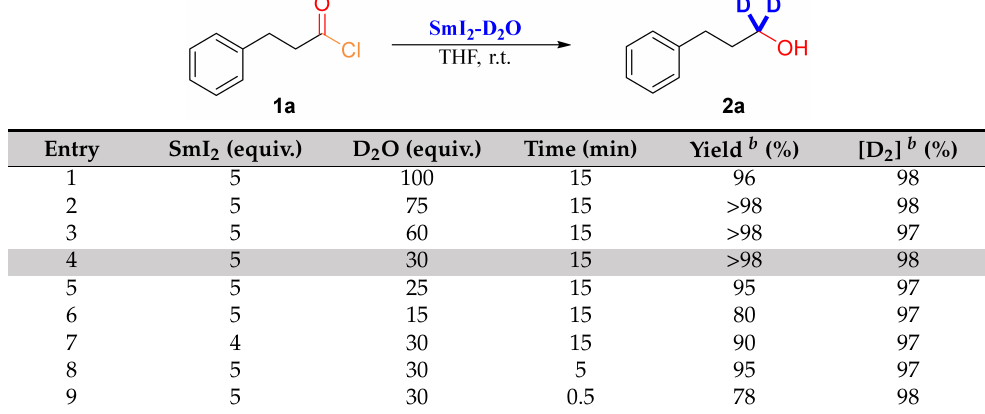
Entry SmI 2 (equiv.) D 2 O